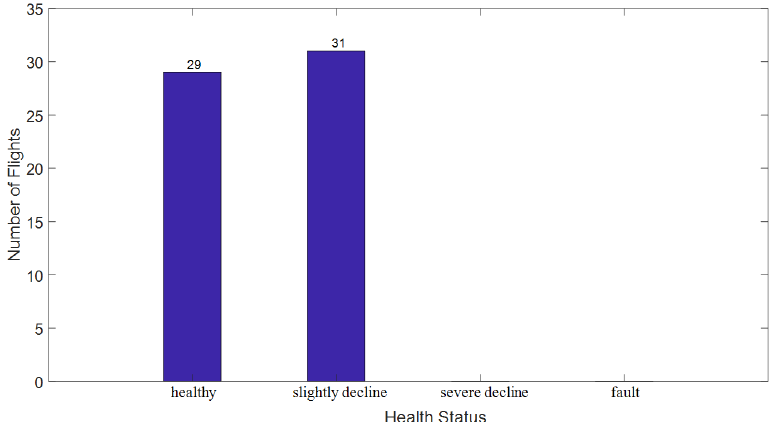
Figure 11. Health status of different flights.